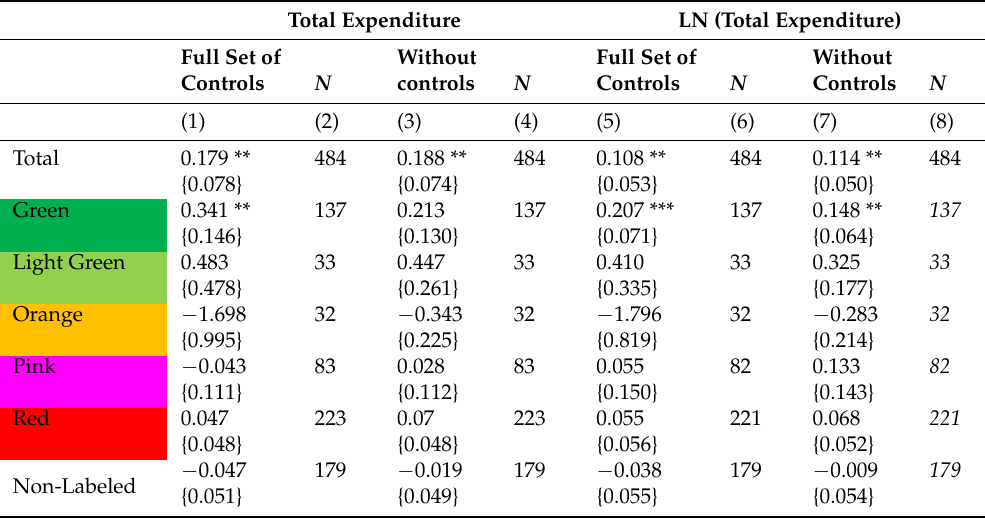
Table A2. Robustness checks for the effect of providing Nutri-Score Label information on expenditure (total and in natural log) by color, conditional on buying at least one item of the respective color.